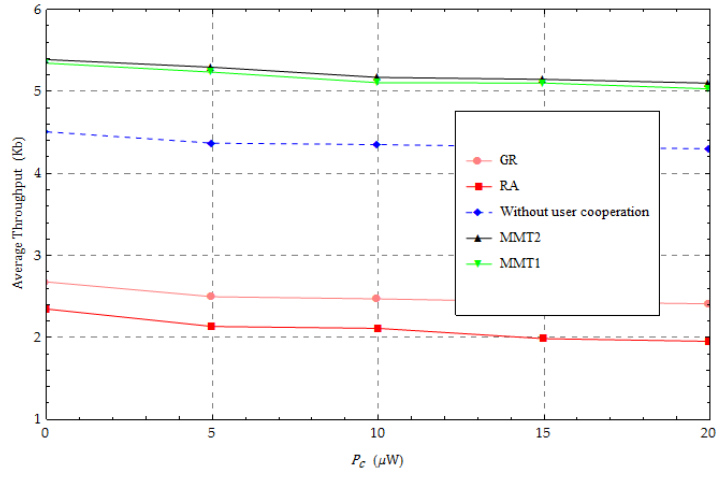
Figure 9. Change in the energy consumption required for transmission.